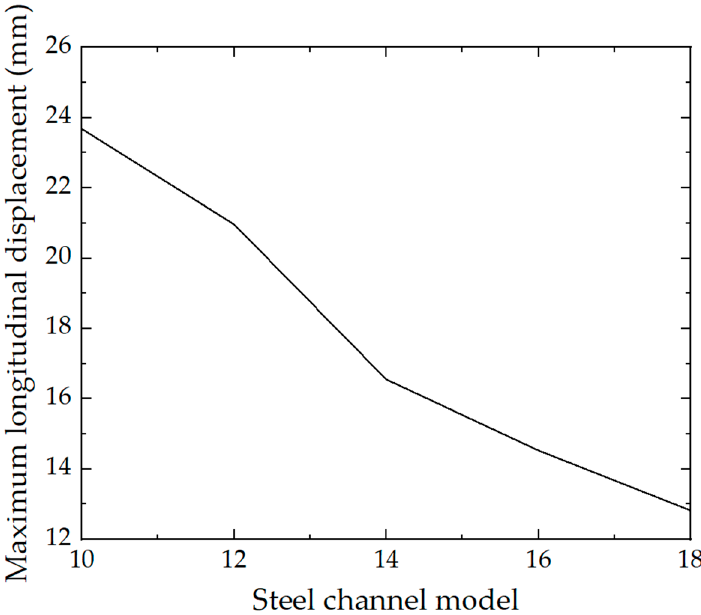
Figure 18. Maximum longitudinal displacement under different models.